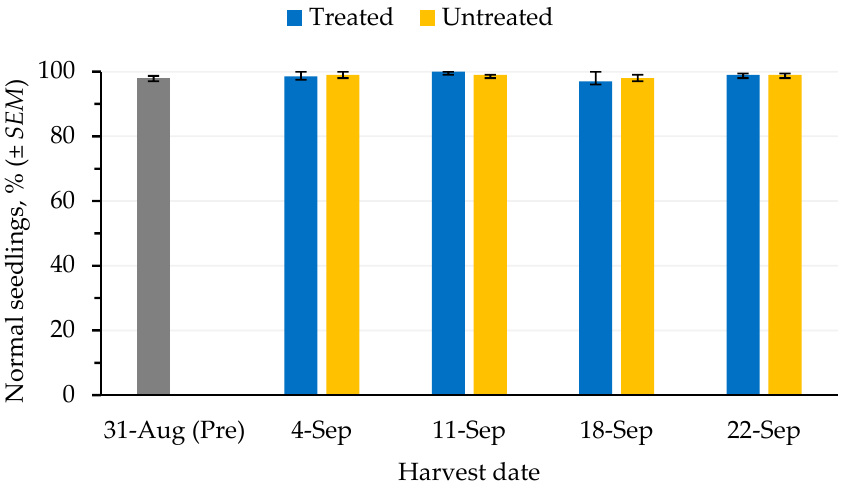
Figure 4. Mean standard germination test values in percentage for corn hybrid seeds harvested at different harvest dates in 2015. 31-Aug (Pre) refers to harvest before defoliant application; all other harvest dates are post-defoliant application. Aug and Sep indicate the months of August and September. Blue columns are the values for seed harvested from plants treated with a defoliant; yellow columns are the values for seed harvested from the untreated control plants. Bars indicate standard error of the mean ( SEM ). Means are not significantly different ( p ≤ 0.05).